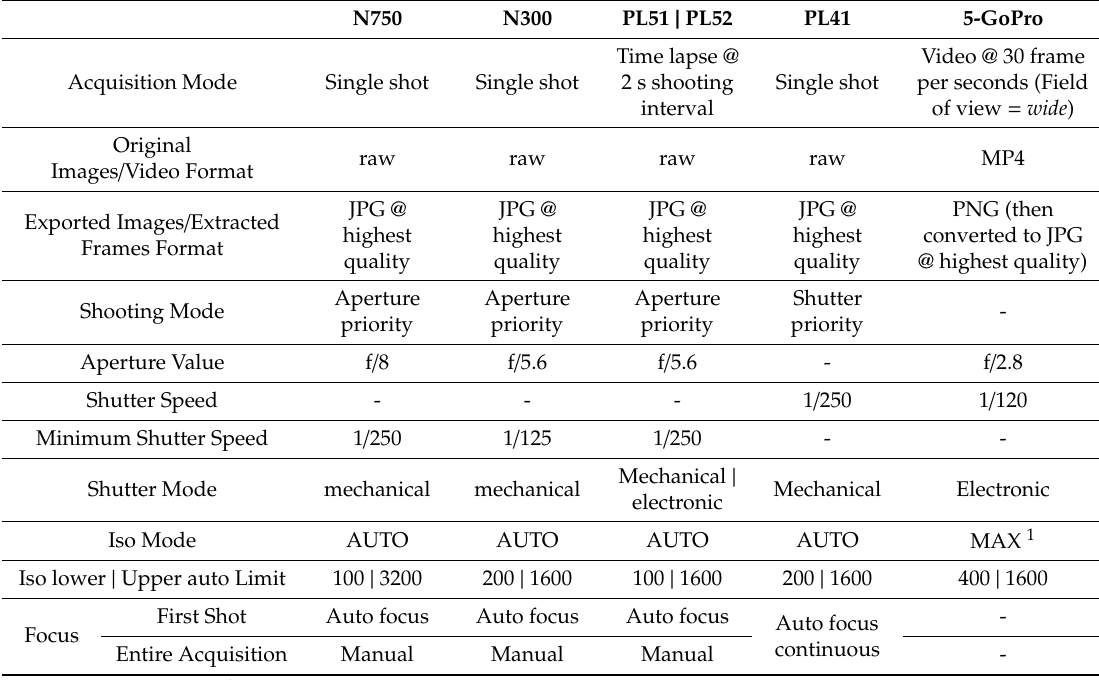
Table 4. Characteristics of underwater photogrammetric systems